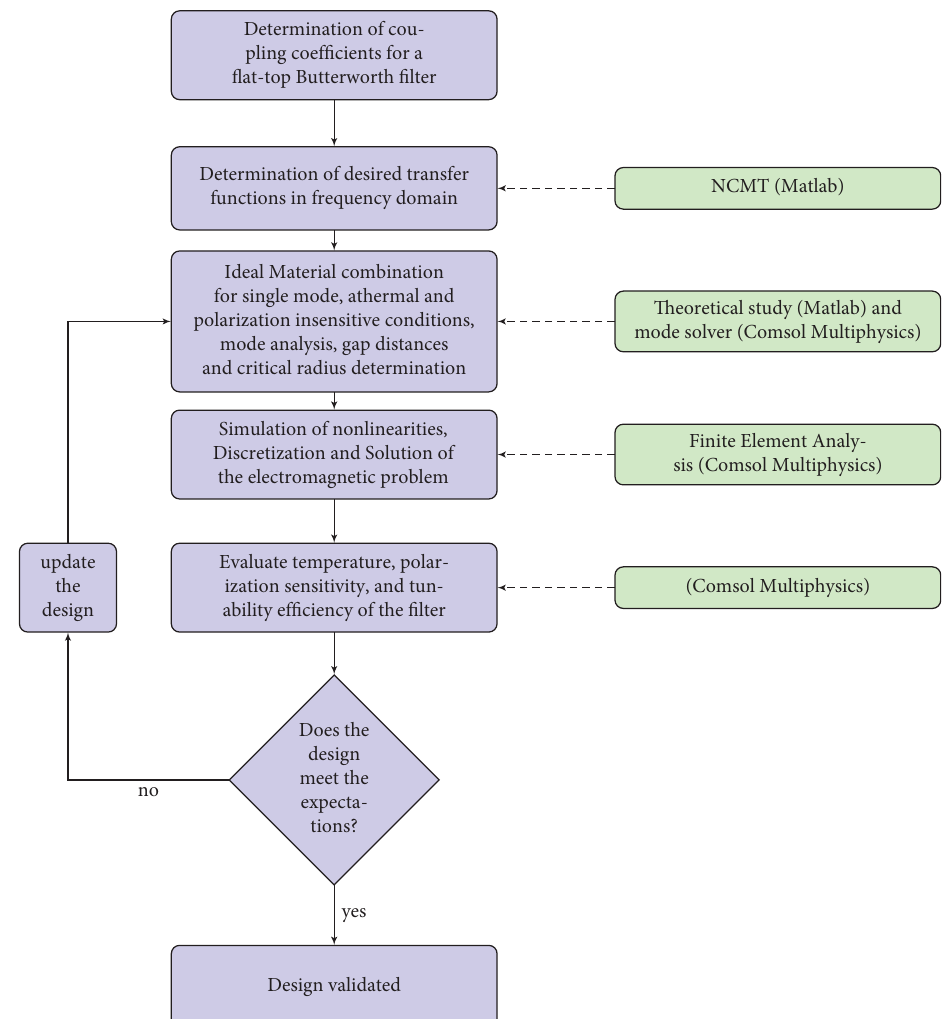
Figure 5: Flow chart of the